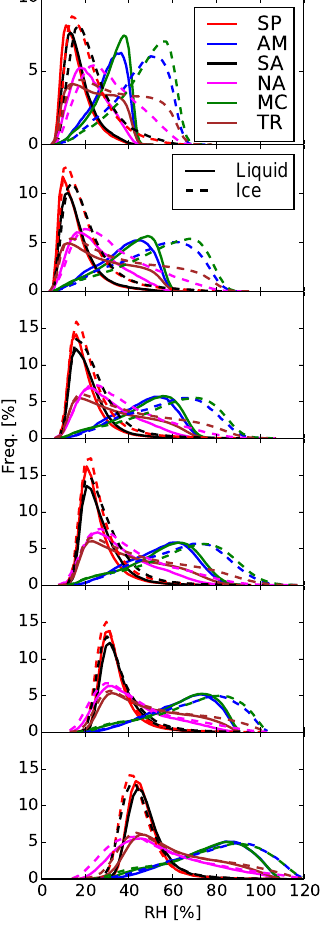
Figure 19. Distribution functions for both RH I and RH L . Depicts from top to bottom are for SAPHIR channels 1–6, respectively. The legend shows the name of the regions which are defined in Table